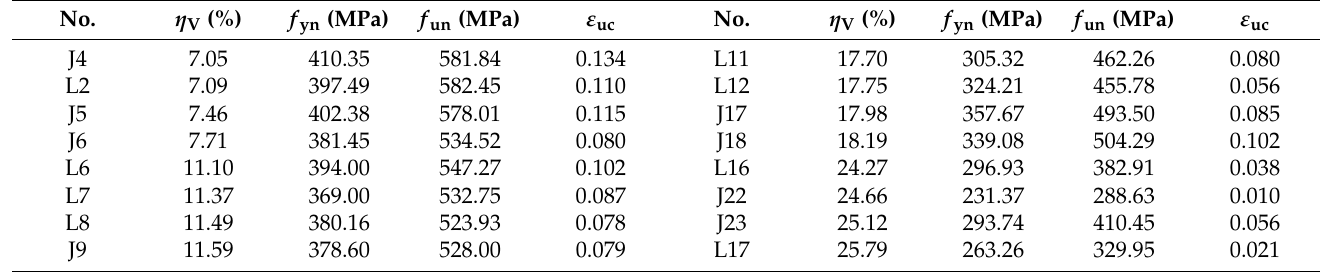
Table 4. Comparison of tensile properties of corroded rebars with similar average corrosion